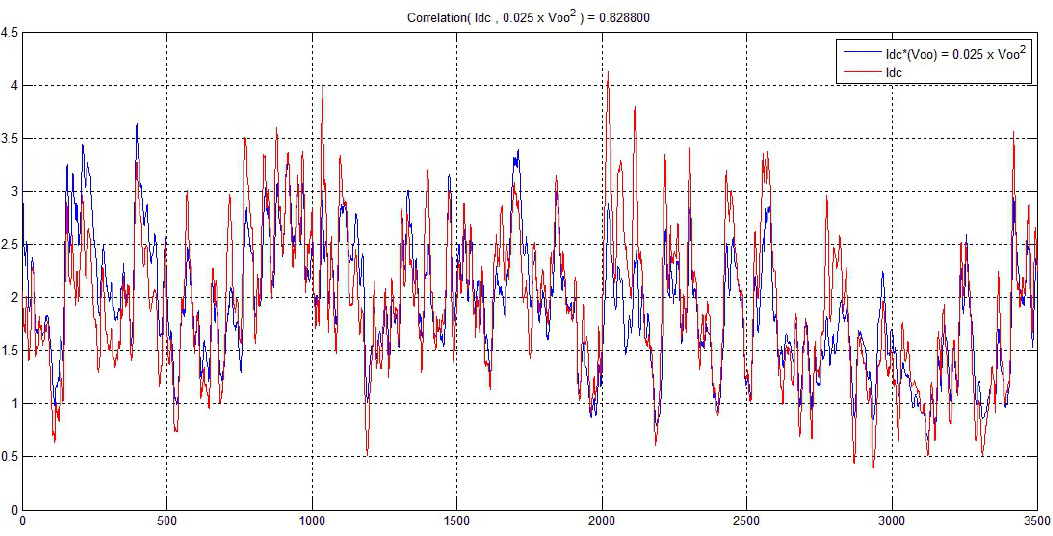
Figure 24. Comparison of the variation in the DC current relative to the quadratic function of the wind speed.